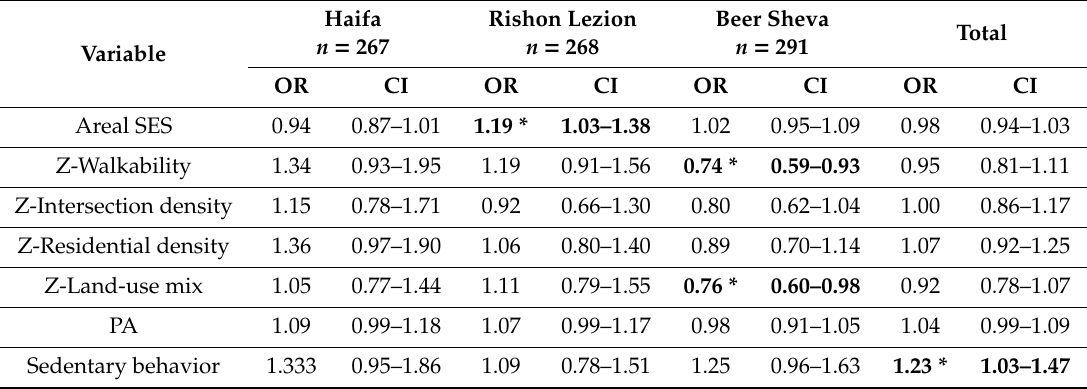
Table 3. Adjusted bivariate regression models predicting adolescents’ Body Mass Index (BMI) by socioeconomic status (SES), the built environment and physical activity